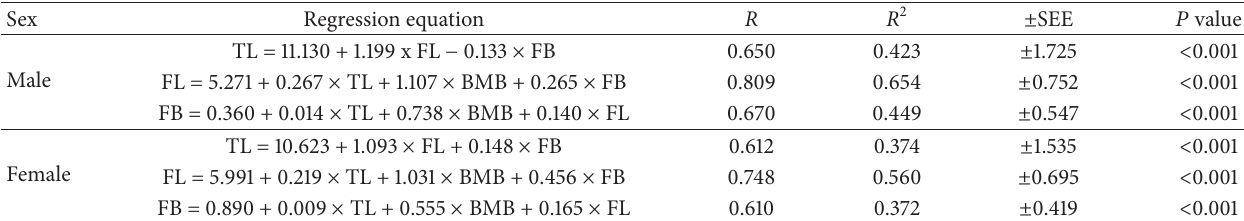
Table 6: Multiple direct regression equations for reconstruction of lower limb dimensions (in